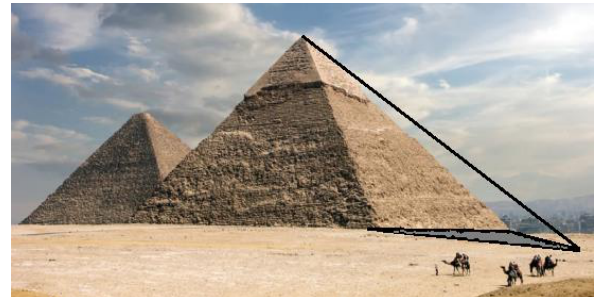
Fig. 5 The Great Pyramid of Cheops (2550 b.C.)